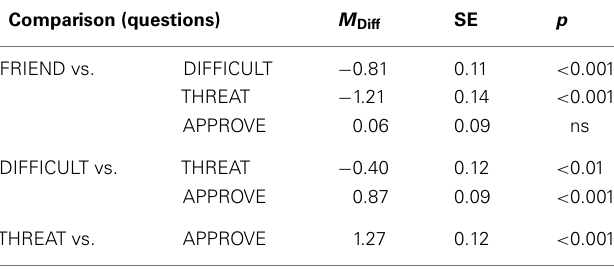
p -values for each pairwise comparison of question type: question 1 (friendliness; FRIEND), question 2 (Difficulty to make contact; DIFFICULT), question 3 (Threat to give presentation;THREAT), and question 4 (approval of group;APPROVE).